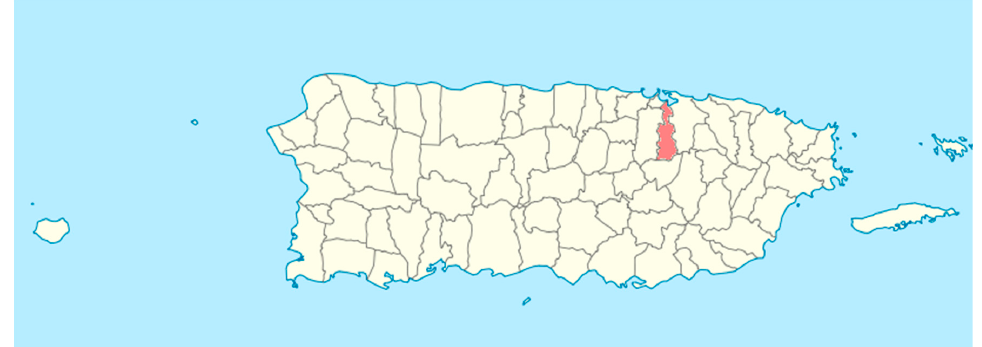
Figure 4. Location of Guaynabo, Puerto Rico. The 82-mile distance between Moca and Guaynabo was easily bridged by ship (later steamer) to the port of Aguadilla. Equirectangular projection, N/S stretching 105 %. Map by Based on File: USA Puerto Rico location map.svg made by NordNordWest, highlighted by Dr. Blofeld—Based on File: USA Puerto Rico location map.svg, CC BY-SA 3.0, https://commons.wikimedia.org/w/index.php?curid=10946699.